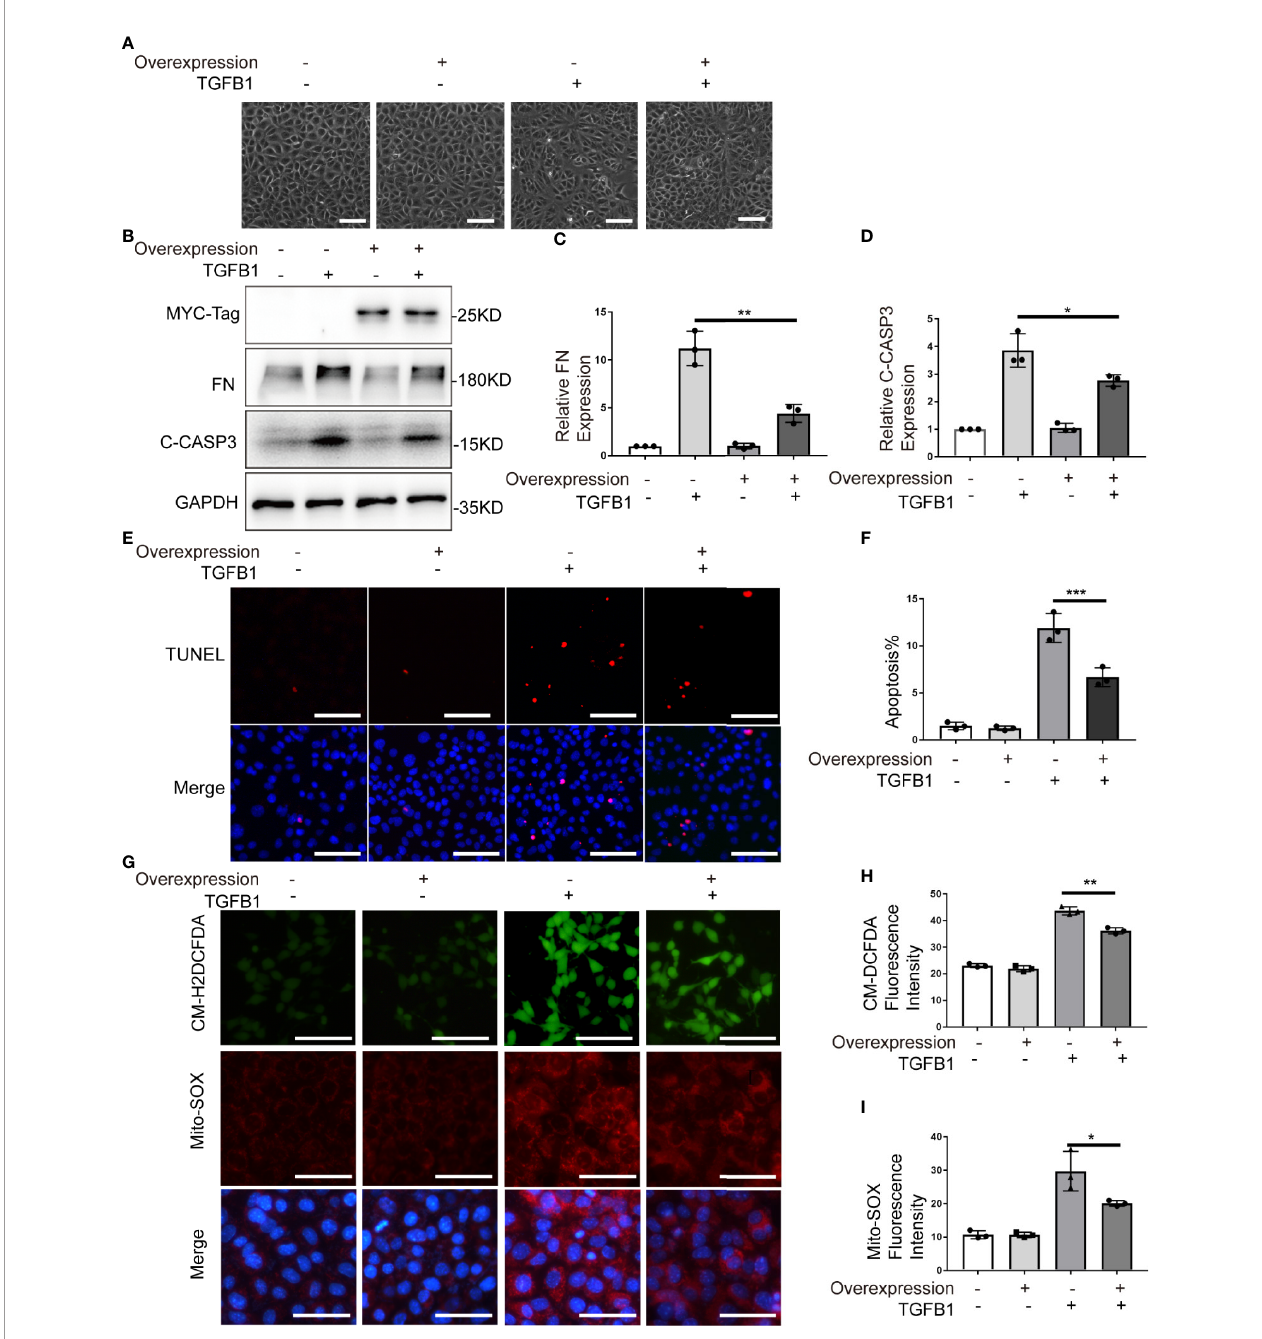
FIGURE 7 | PARK7 overexpression attenuates TGFB1-induced pro fi brotic changes, apoptosis and ROS production. BUMPT cells were transfected with PARK7 overexpression plasmid or empty vector, and 24 hours after transfection, the cells were cultured in medium with/without 5 ng/ml TGFB1 for another 24 hours. (A) Representative images of cell morphology. Bar: 100 m m. (B) Representative immunoblot of Fibronectin (FN), cleaved/activated caspase 3(C-CASP3), MCY-Tag and GAPDH (protein loading control). (C, D) Densitometry of FN and C-CASP3 (n=3). The signal of FN, or C-CASP3 was normalized to the GAPDH signal of the same samples to determine the ratios. The values are expressed as fold change over control cells without Park7 overexpression. (E) Representative images of TUNEL assay and DAPI staining (X200). Bar: 100 m m. (F) Apoptosis percentage (n=3). Greater than 200 cells in each group were evaluated to determine the percentage of TUNEL-positive cells. (G) Representative images of CM-H2DCFDA and Mito-SOX staining. Bar: 100 m m in the CM-H2DCFDA image, 50 m m in the Mito-SOX and Merge images. CM-H2DCFDA and Mito-SOX staining was performed to evaluate intracellular and mitochondrial ROS, respectively. (H, I) Quanti fi cation of CM-H2DCFDA and Mito-SOX fl uorescence intensity (n=3). Each symbol (circle, diamond and trigon) represents an independent experiment. Error bars: SEM. *p < 0.05, **p < 0.01, ***p <